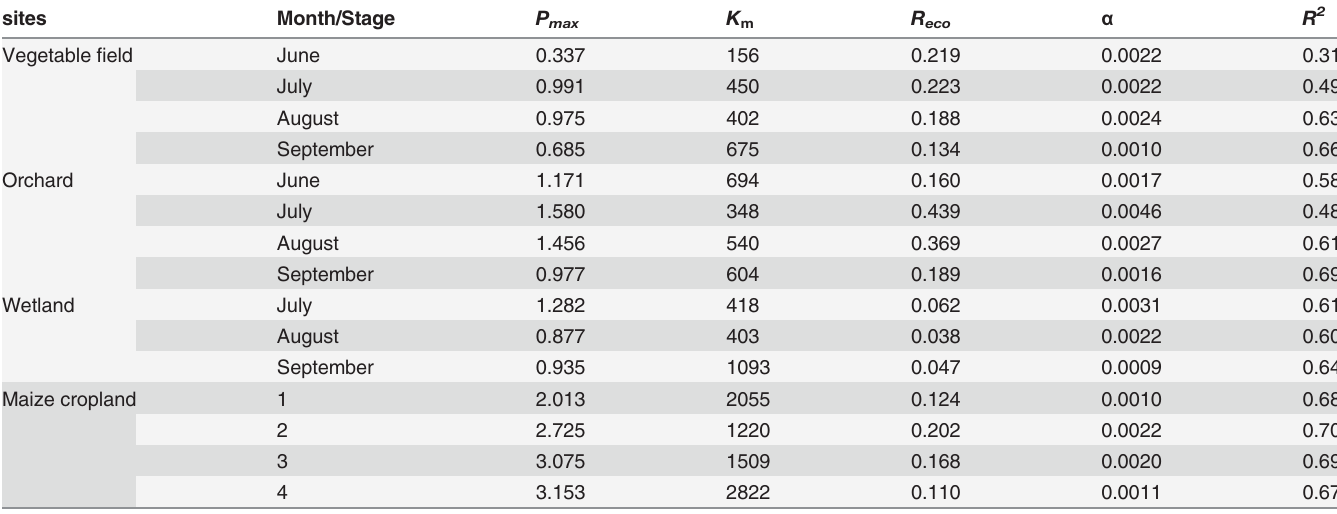
Table 4. Seasonal dynamics of light-response parameters for different ecosystems. sites Vegetable fi eld